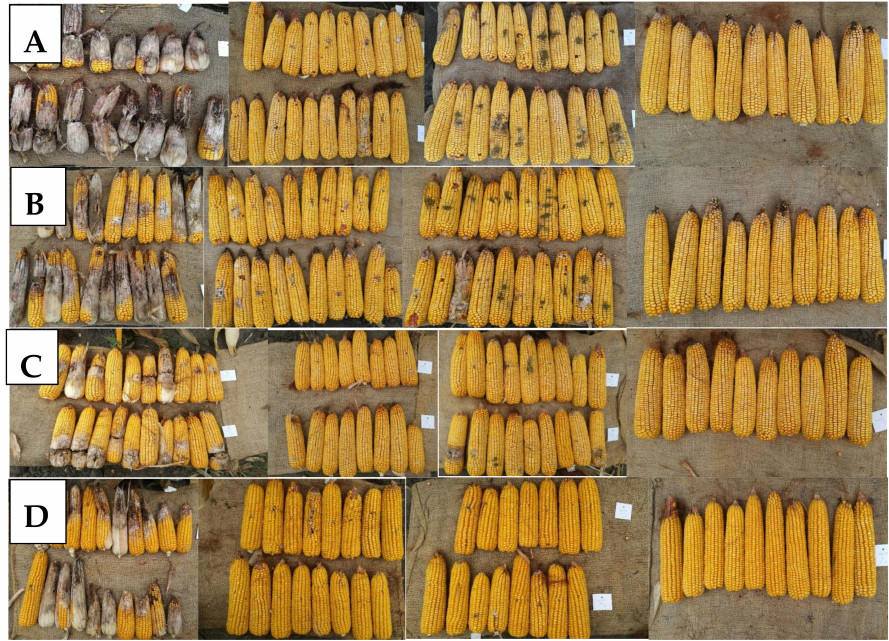
Figure 7. Visual symptoms of toxigenic fungi in 2019. F. graminearum is the first column on the left, followed by F. verticillioides , A. flavus, and the naturally infected control to the right. ( A ) P9415; ( B ) DKS 4541 (susceptible control); ( C ) Korimbos (resistant control); ( D ) Valkür. Columns 1–3: upper row: Isolate 1; lower row: Isolate 2; control contains one